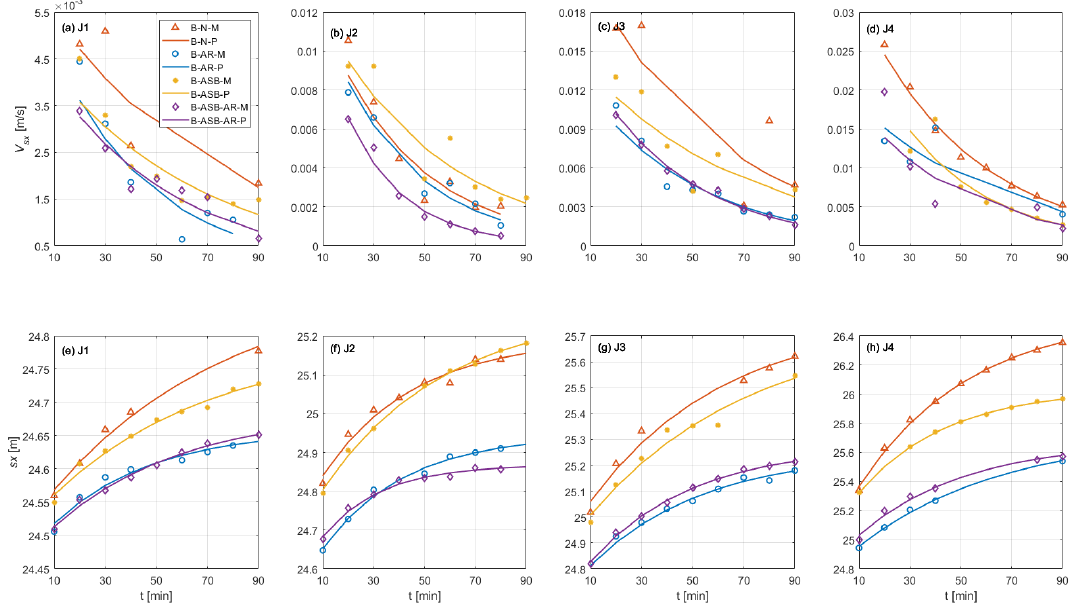
Figure 6. Comparison of time-varying process of V sx and sx between measurement (marks) and prediction (line) ( a – h . Table 3. Fitting parameters with evaluations of the exponential model on scarp evolution. (SSE: The sum of squares due to error; RMSE: Root mean squared error; Adjusted R-square: Degree-of-